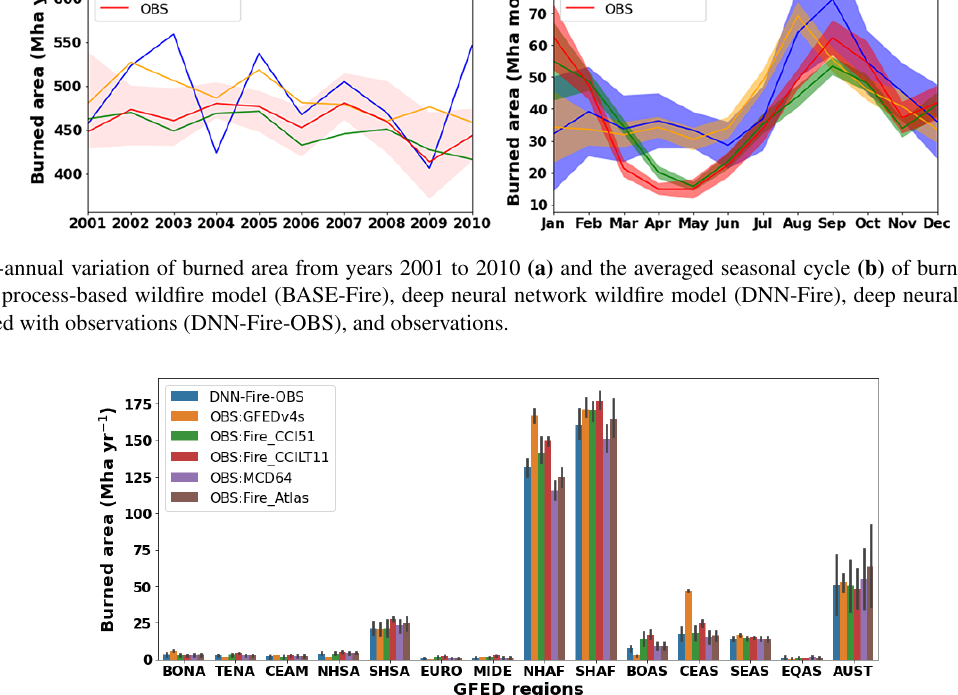
Figure 6. Prognostic simulation of annual wildfire burned area with the deep neural network wildfire model fine-tuned with observations (DNN-Fire-OBS) compared with five burned area products (Table S1) over 2011–2015 for 14 GFED